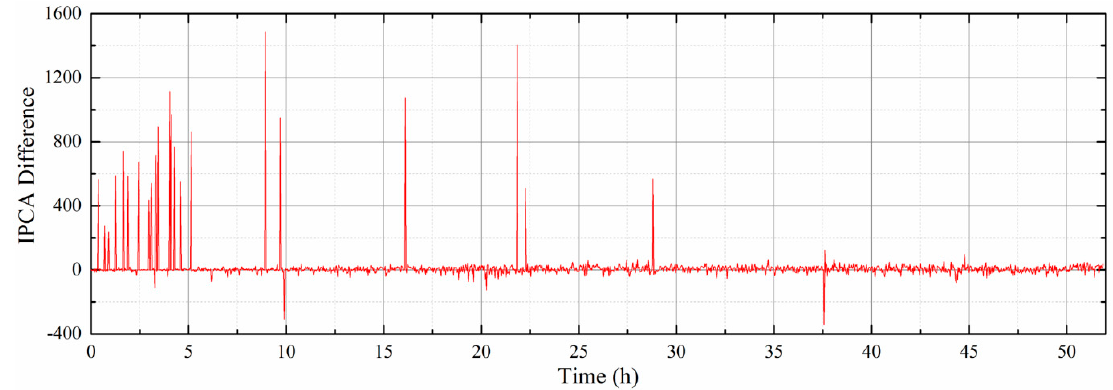
Figure 14. IPCA difference of two methods.